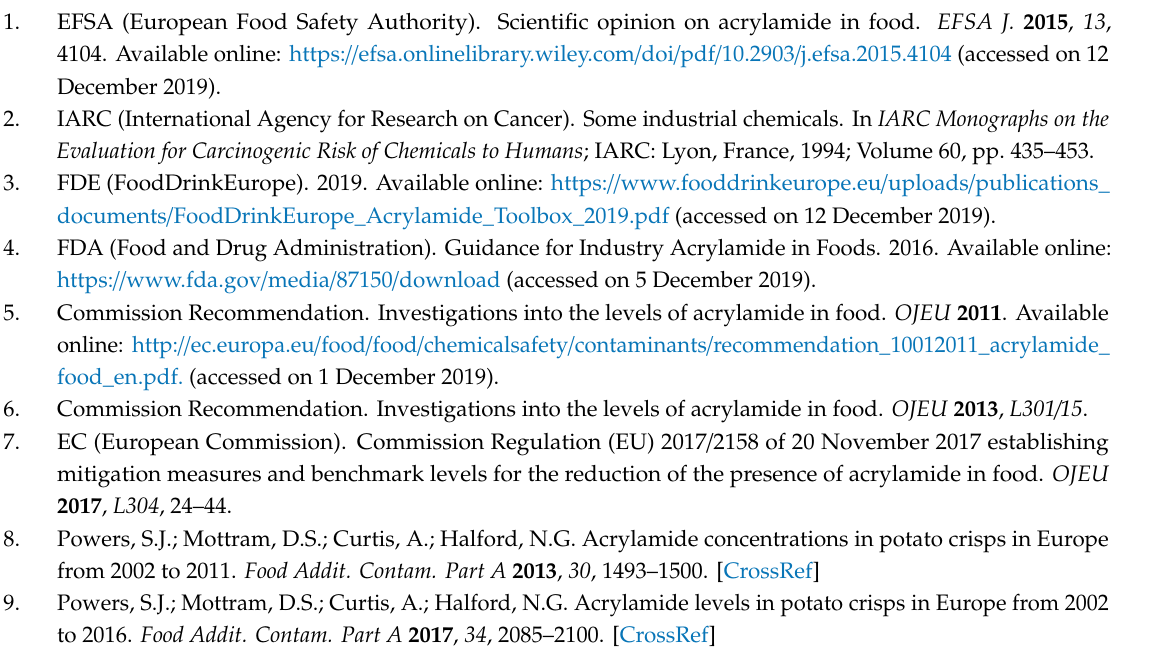
Table S1. Average nutritional composition of the whole dataset of potato crisps as provided by the manufacturer. Data are expressed as mean ± standard deviation (SD) per 100 g of